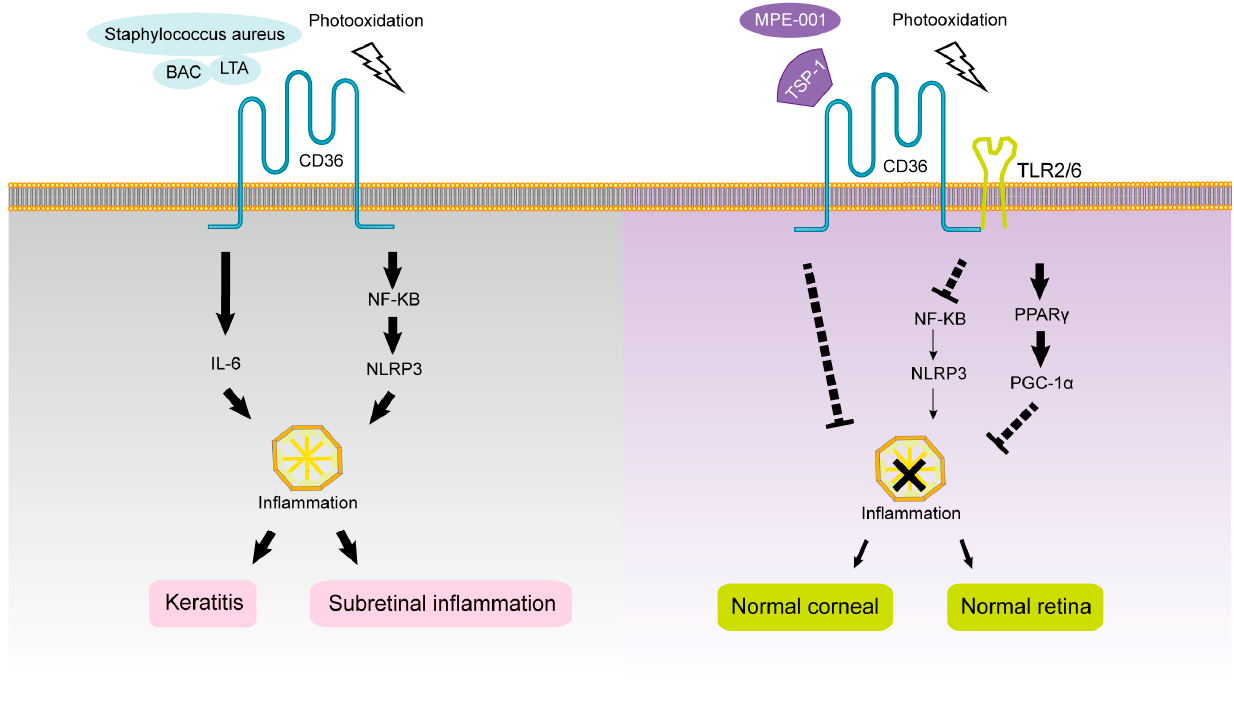
Figure 5. The roles of CD36 in intraocular inflammation.